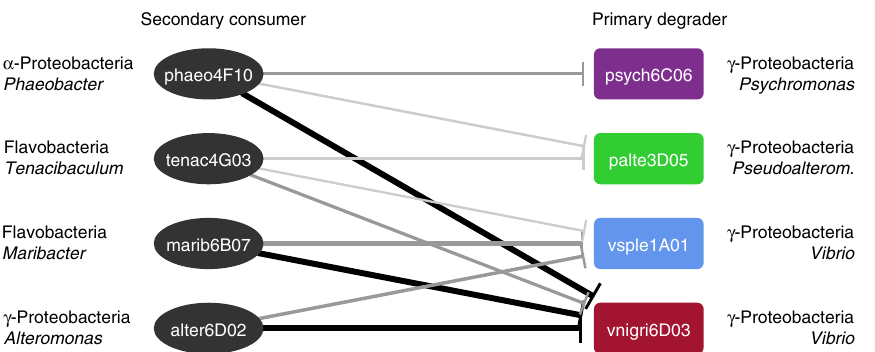
Fig. 4 Degradation inhibition is speci fi c to functional groups, not strains. The network depicts the effect of four different secondary consumers from diverse taxonomic origins on the characteristic particle half-life τ 1/2 induced by different primary degraders. Network edge width is proportional to τ 1 = 2 coculture τ are drawn between secondary consumers and primary degraders when the mean ( n = 3) half-life τ 1/2 determined from the degradation curves of monoculture and cocultures was statistically different according to a one-way ANOVA. Black: complete inhibition, dark gray: p < 0.05, light gray: p < 0.1, respectively. See Supplementary Figs. 9, 10 and Supplementary Table 3 for raw